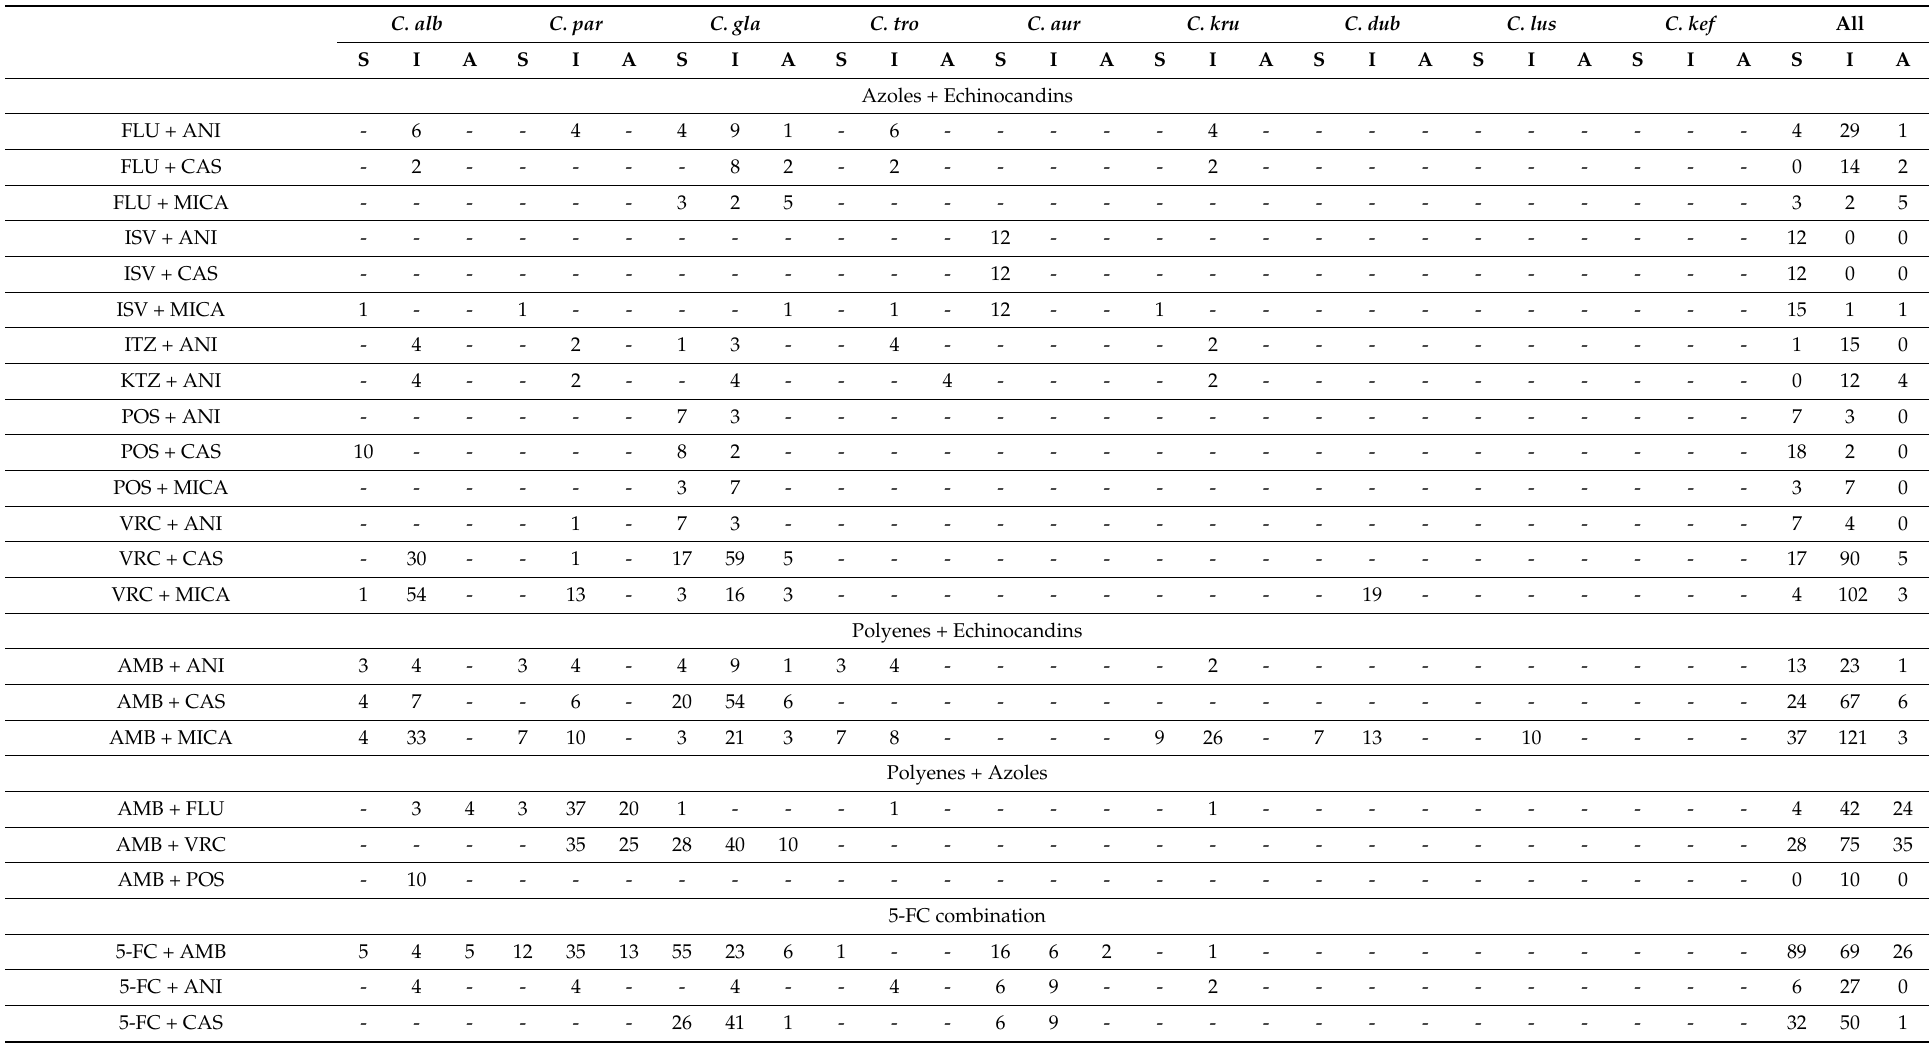
Table 1. Cumulative number of in vitro combinations results reported in the studies